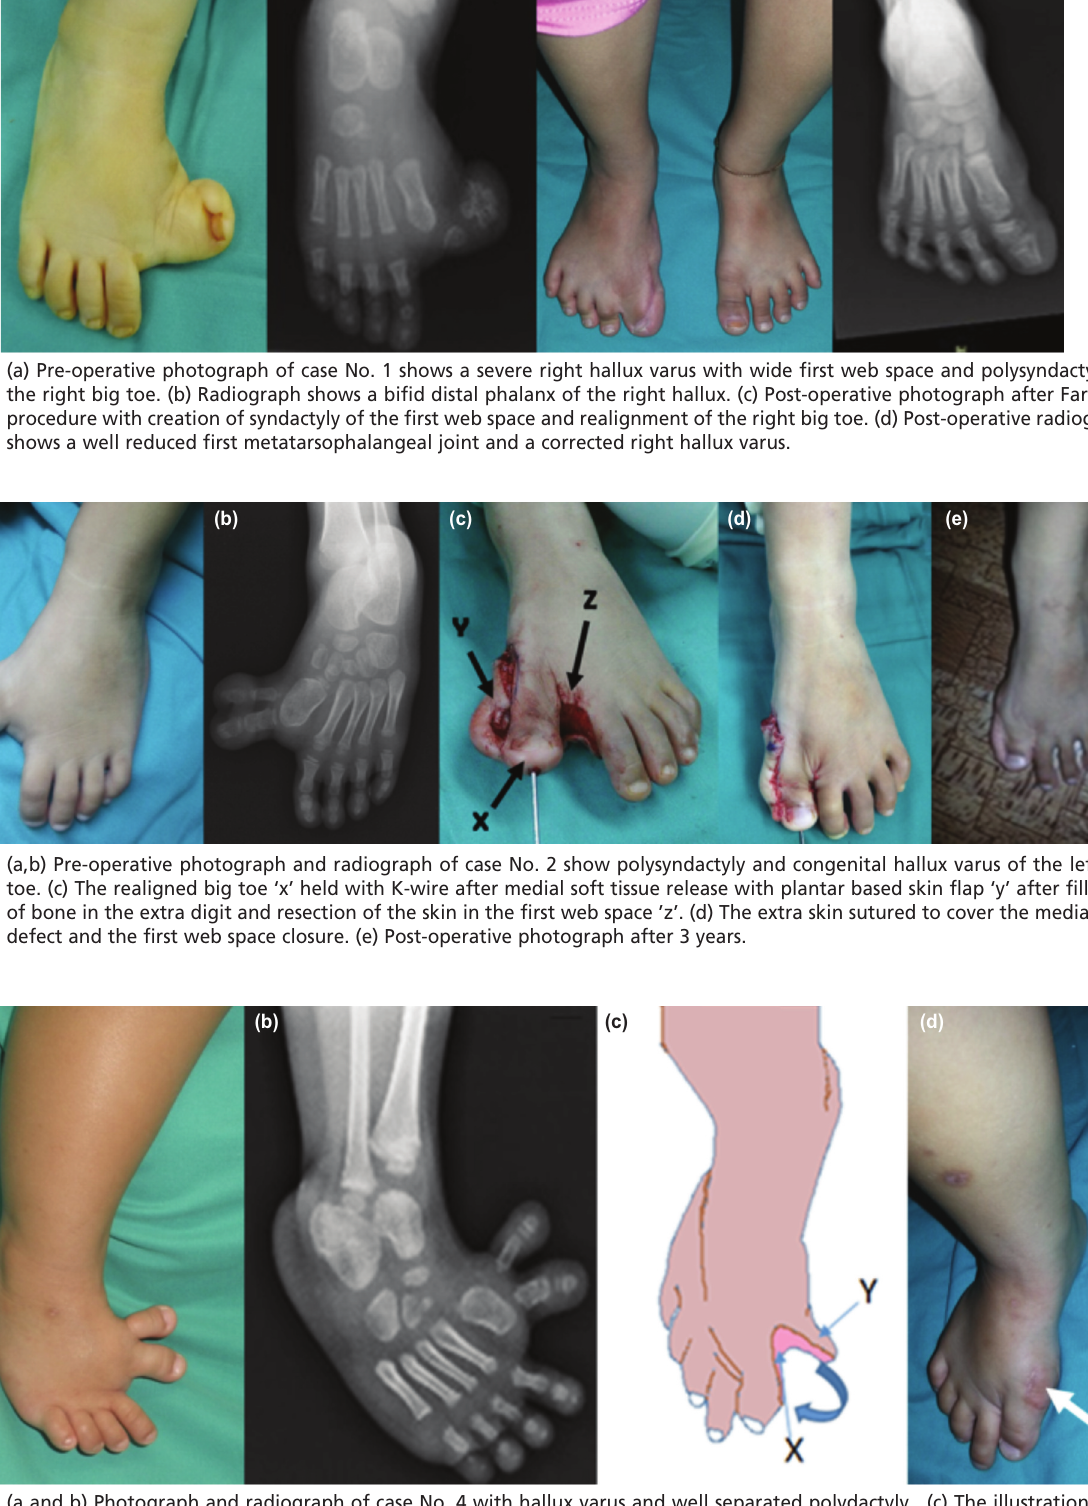
(a and b) Photograph and radiograph of case No. 4 with hallux varus and well separated polydactyly. (c) The illustration with Fig. 3: arrow ‘x’ showing a skin defect after realignment of the big toe and arrow ‘y’ showing the proximal based skin flap created from resection of the bone and soft tissue from accessory medial toe. (d) Post-operative photograph one year after the modified reconstruction procedure with arrow ‘z’ showing a healed proximal based skin